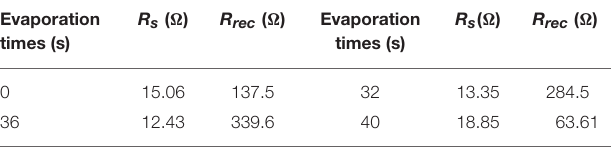
TABLE 2 | The series resistances R S and the recombination resistance R rec values of the perovskite solar cells with varying BCP evaporation times. Evaporation times